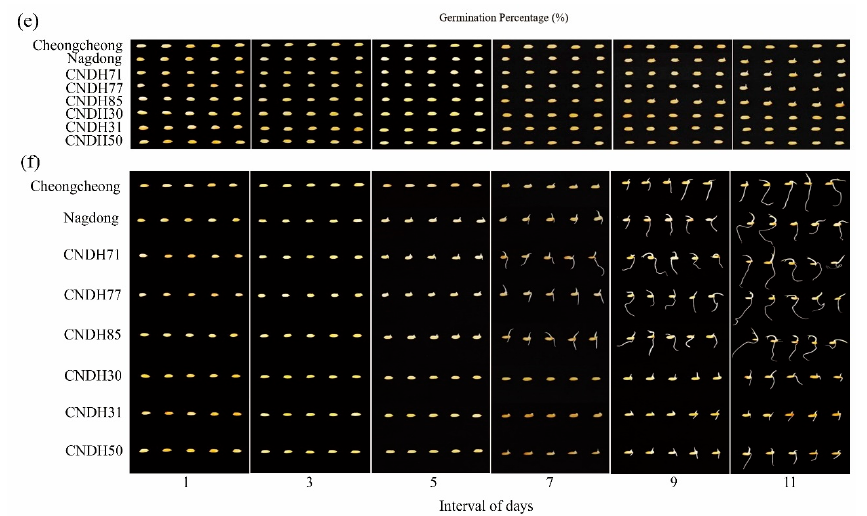
Figure 1. Representation of seed germination and frequency distribution. ( a , b ) Represent the GP of Cheongcheong and Nagdong on the daily basis under LDT conditions. ( c , d ) Shows frequency distribution for GP under the 15 ◦ C and 20 ◦ C conditions of CNDH population. ( e , f ) The seed germination pattern under 15 ◦ C and 20 ◦ C conditions. The highest GP in CNDH population is CNDH71, CNDH77, and CNDH85. The lowest GP in CNDH population is CNDH30, CNDH31, and CNDH50. All pictures were taken every two days after the seeds start germination. C; Cheongcheong, N; Nagdong, R1; replicate 1, and R2; replicate 2.